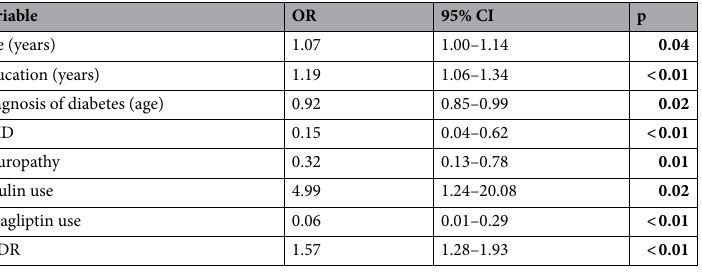
Table 3. Logistic regression analysis of factors associated in patients with LADA. Significant values are in [bold]. LADA, Latent autoimmune diabetes in adults; T2D, Type 2 diabetes; DKD, Diabetic kidney disease; eGDR, Estimated glucose disposal rate. We used binary logistic regression. A p-value < 0.05 was considered significant.